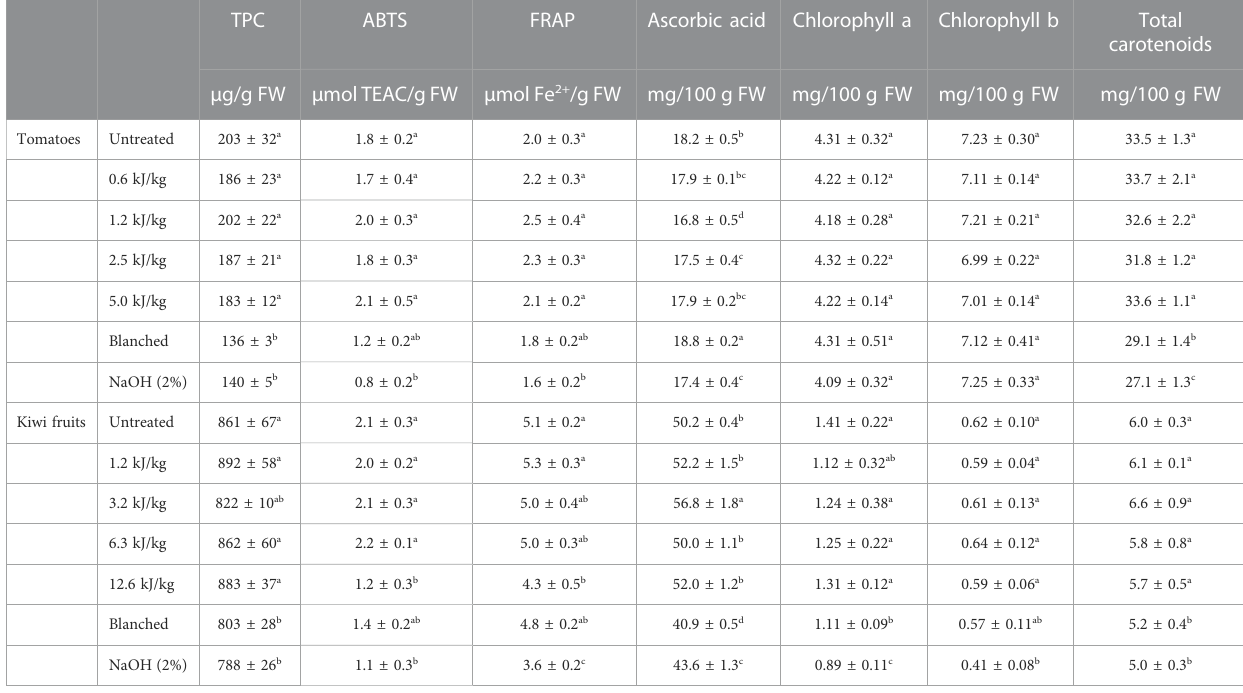
TABLE 3 Total phenolic content (TPC), antioxidant activity as ABTS and FRAP, ascorbic acid content, chlorophylls a and b and total carotenoids content for untreated, PEF treated (at different energy inputs, kJ/kg), blanched and lye peeled tomatoes and kiwi fruits. Different letters in the same column of each raw material indicate signi fi cant differences ( p <